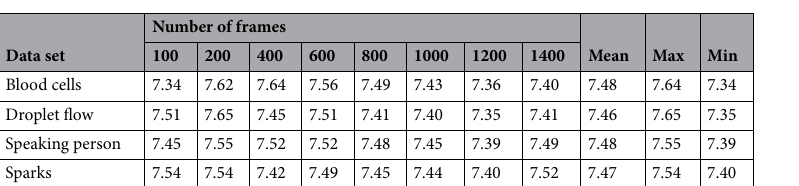
Table 1. Information entropy of encrypted images at various compression rates.